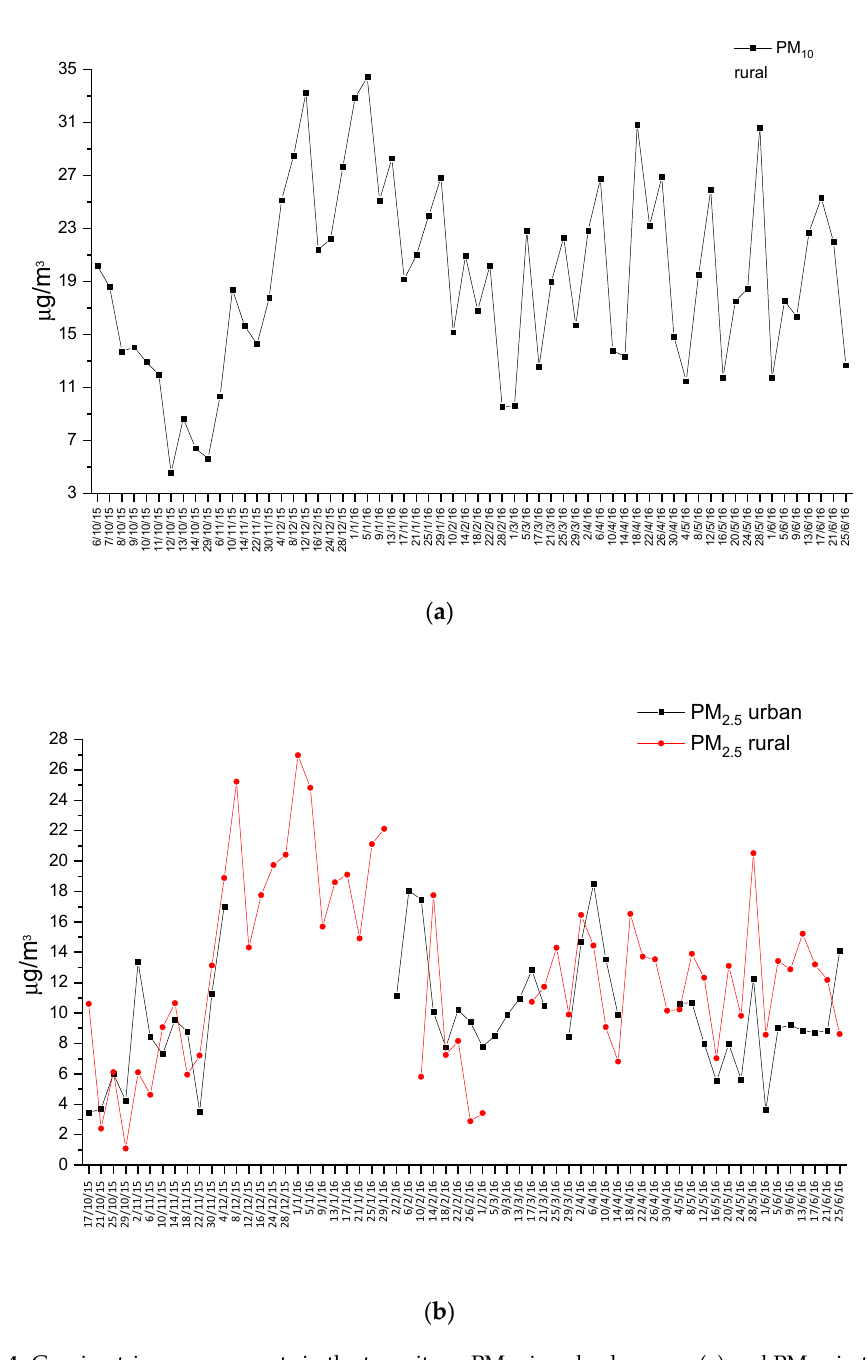
Figure 4. Gravimetric measurements in the two sites—PM 10 in suburban area ( a ) and PM 2.5 in the two sites ( b ).